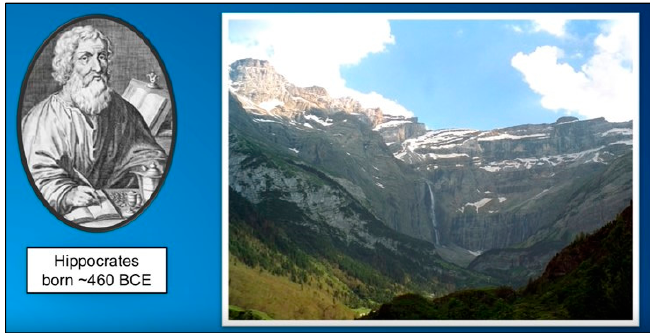
Figure 1. Hippocrates and relationship between health and place. ( Source: [1]).